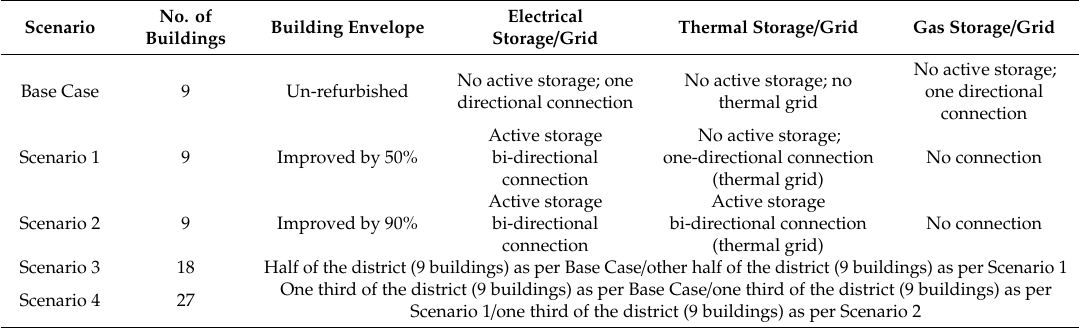
Table 1. Description of energy related properties for base case and scenarios, extended from